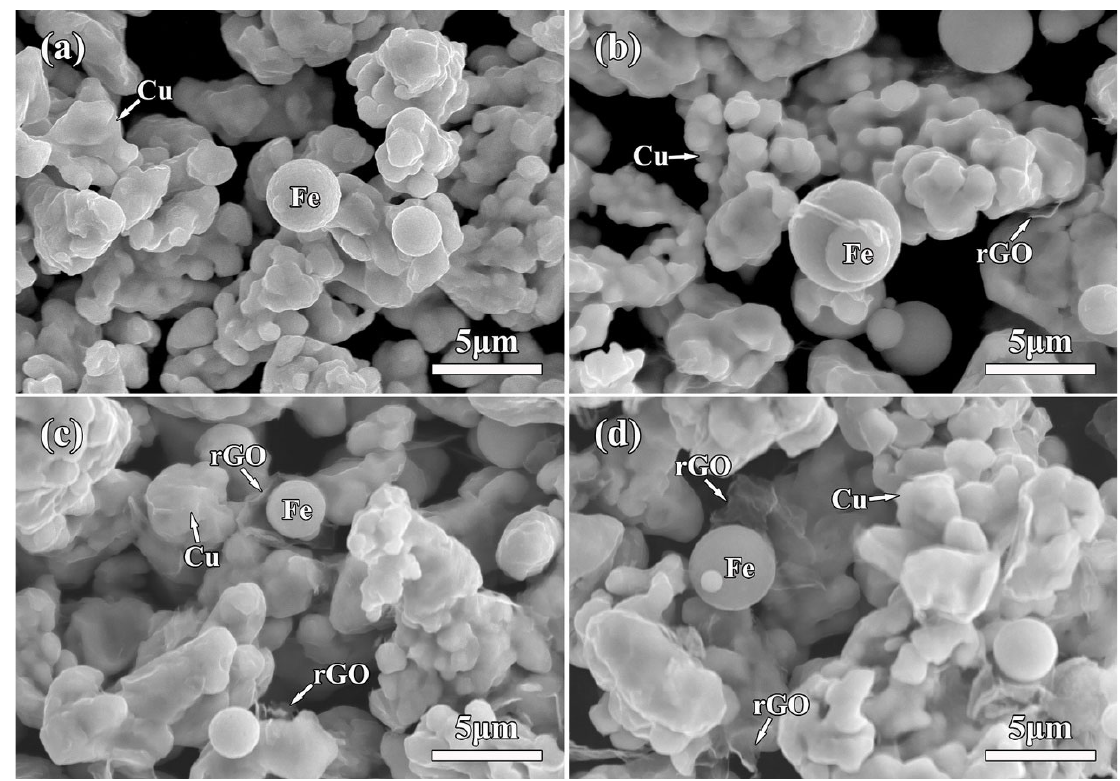
Figure 3. Low-magnification SEM micrographs of the as-prepared mixture powders: ( a ) 0rGO, ( b ) 1rGO, ( c ) 2rGO, ( d ) 3rGO.